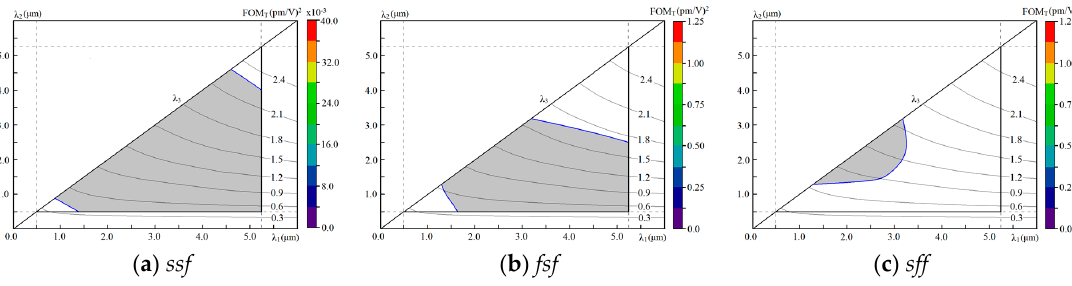
Figure 16. FOM T ( λ 1 , λ 2 ) distribution for CTA crystal for all types of interactions: ( a ) ssf , ( b ) fsf , ( c ) sff.